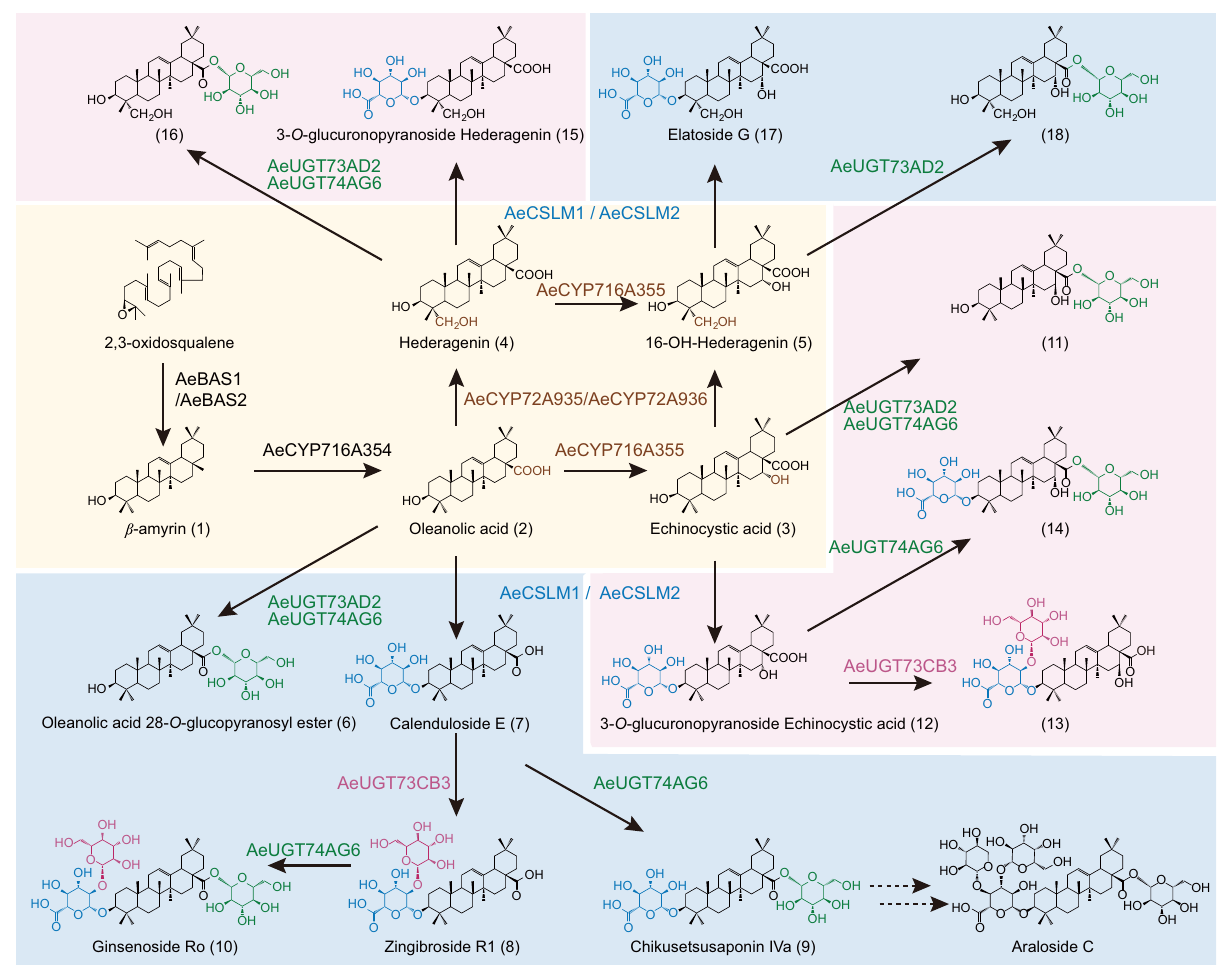
Fig. 7 Overview of araloside structures and their biosynthesis in A. elata . The light-yellow box indicates the cyclization of 2,3-oxidosqualene to β -amyrin and CYP-catalyzed hydroxylation of triterpenoids. The boxes in other colors represent the glycosylation of different triterpene backbones. Brown letters indicate hydroxylation reactions catalyzed by cytochrome P450 monooxygenases (P450s); blue letters indicate glycosylation reactions catalyzed by cellulose synthase-like glycosyltransferase (CSL); green letters indicate C28 glycosylation reactions catalyzed by UDP-dependent glycosyltransferases (UGTs); and purple letters indicate C3 – 2 glycosylation reactions catalyzed by UGTs. Reaction sites are indicated in the corresponding colors. Broken arrows indicate putative araloside biosynthesis